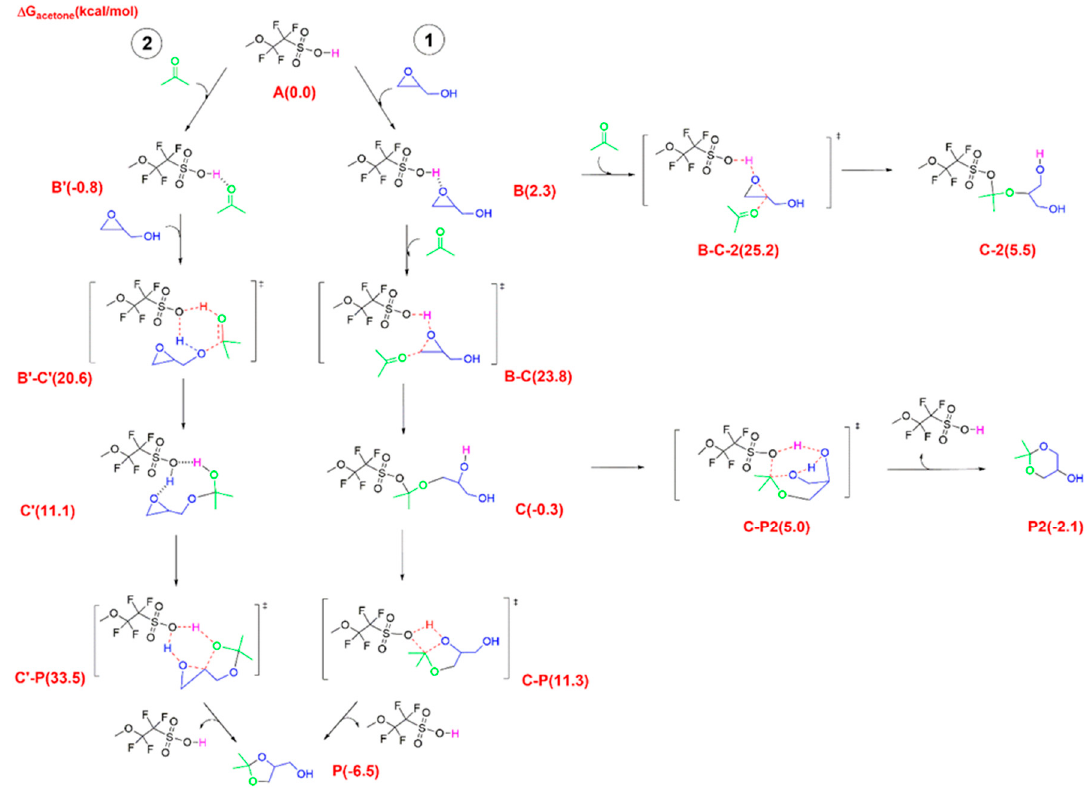
Figure 2. Mechanistic pathways investigated and corresponding free energies (kcal/mol in acetone).